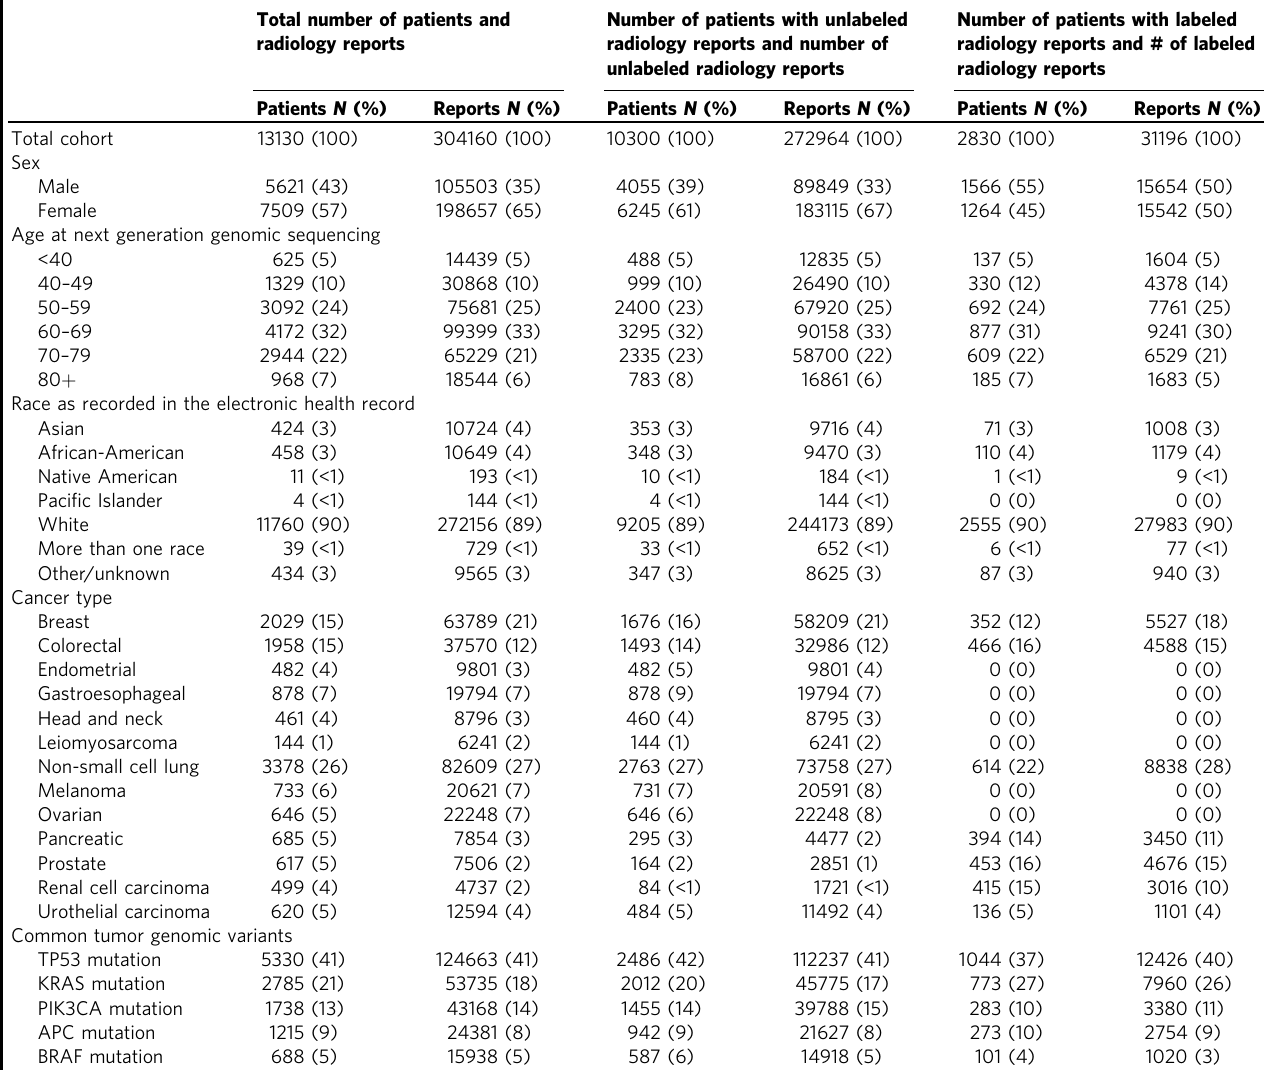
Table 1 Characteristics of patients with radiology reports for